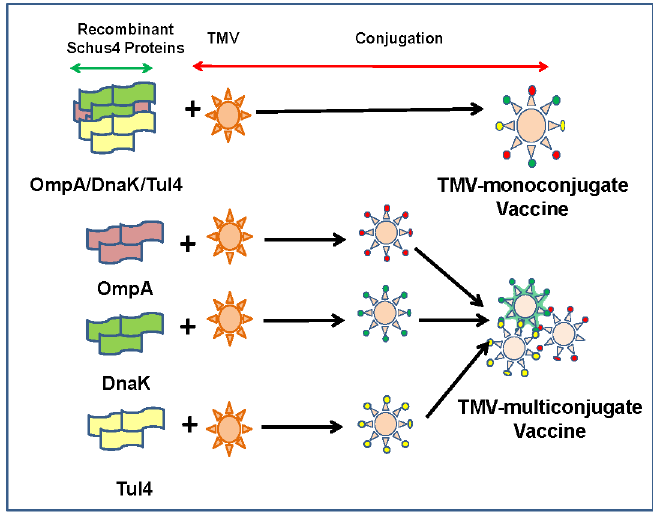
Fig 1. Vaccine Formulations. Two different vaccine formulations were used. In thefirst vaccineformulation all three recombinantproteins OmpA, DnaKand Tul4 were conjugated to a single TMV virion(TMV-monoconjugate vaccine). The second vaccine formulation contained each recombinant protein of F . tularensis conjugated individually to TMV and then mixedin equalconcentrations to generate a TMV-multiconjugate